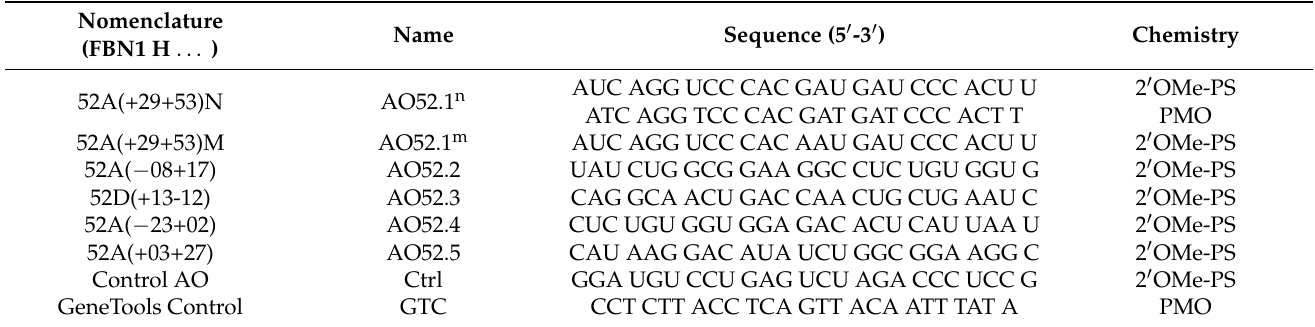
Table 1. Antisense oligonucleotide binding coordinates and sequences.